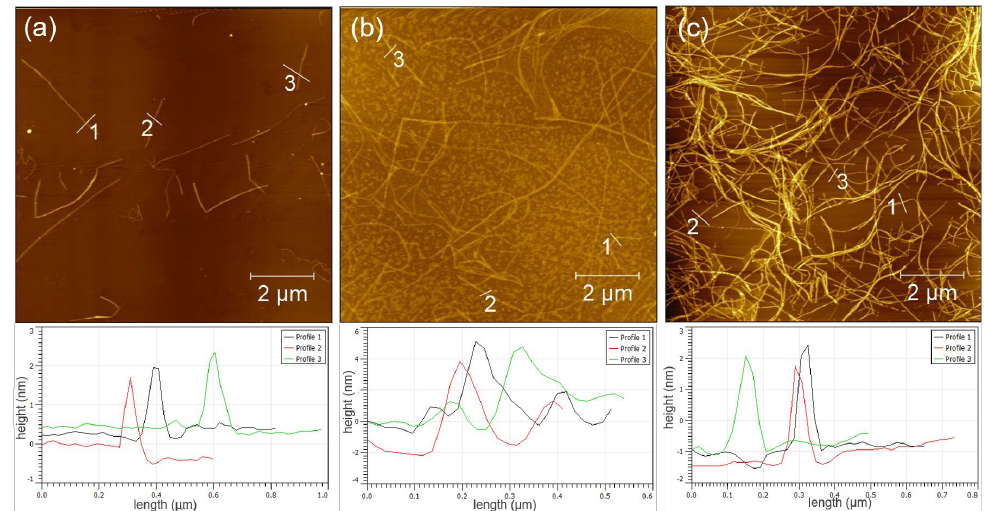
Figure 1. AFM images and cross − sectional analysis of KIIIIKYWYAF peptide nanofibers at different incubation times: ( a ) 24 h, ( b ) 48 h, and ( c ) 72 h.